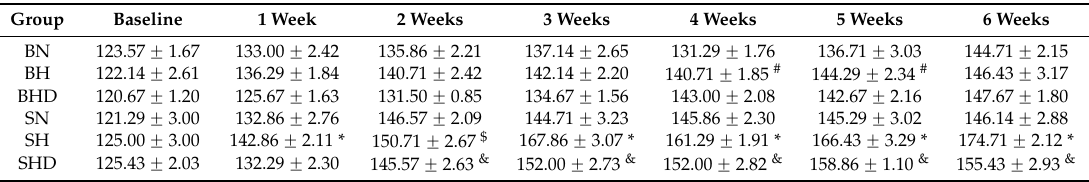
Table 2. The SBP in male rats after 6 weeks of